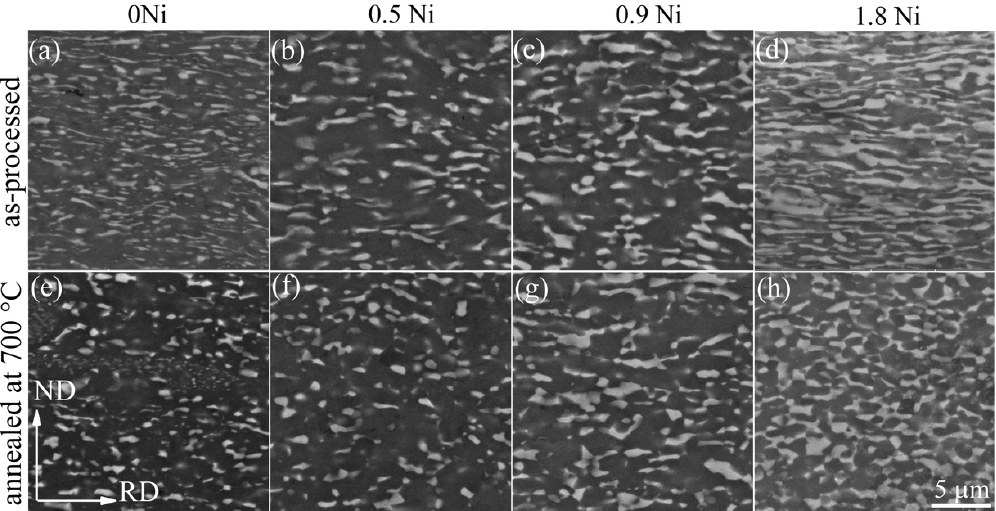
Figure 2. SEM images of ( a – d ) hot-rolled sheets at 750 °C and ( e – h ) annealed sheets at 700 °C (30 min) for the ( a , e ) 0Ni alloy, ( b , f ) 0.5Ni alloy, ( c , g ) 0.9Ni alloy, and ( d , h ) 1.8Ni alloy. The α / β phase ratio depends on the rolling temperature, which influences the as- processed microstructure [2,42]. The hot-rolling temperature of 750 °C provided 20% of the β phase for the 0.5Ni alloy, 25% for the 0.9Ni alloy, and 35% for the 1.8Ni alloy. In addition, rolling was performed at a lower temperature of 700 °C to provide a similar β -phase fraction of ~20–25% for the 1.8Ni alloy (Figure 3). The 1.8Ni alloy demonstrated a significant difference in the microstructure after processing at 750 and 700 ◦ C. The microstructure contained the α and β phases and bright particles with a mean size of 1.1 ± 0.1 µ m and a volume fraction of ~1% (Figure 3a). The EDS analysis showed a high Ni content in these particles (Figure 3b). The XRD analysis in the as-rolled state detected the presence of the Ti 2 Ni phase in addition to the α , β , and TiB phases (Figure 3c). It